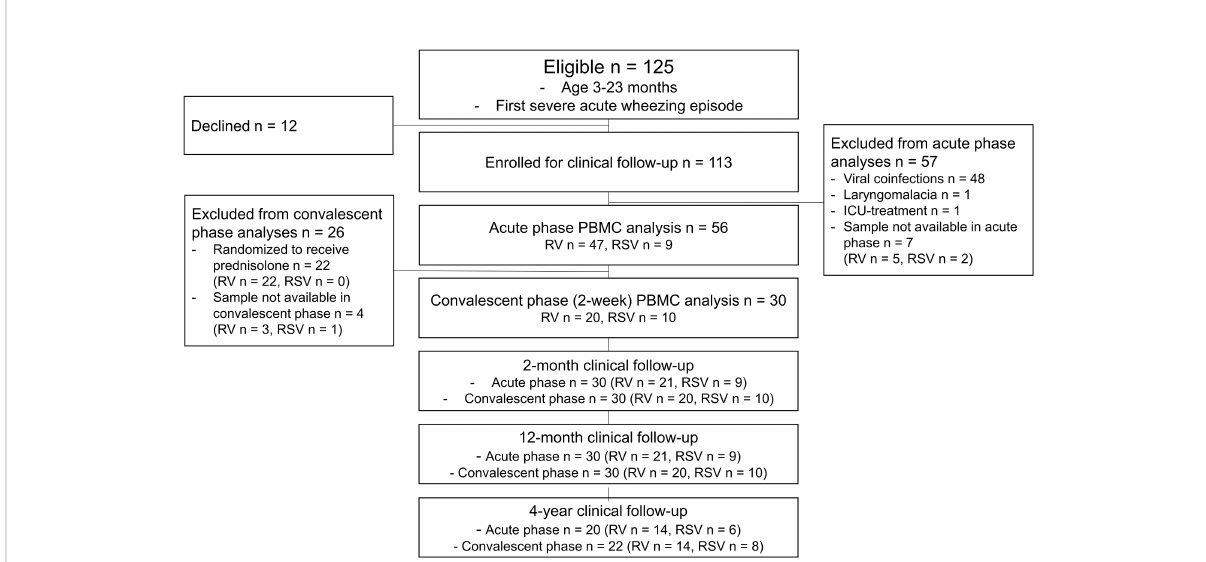
FIGURE 1 Study fl owchart. Patients with cytology data were included. ICU, intensive care unit; PBMC, peripheral blood mononuclear cell; RSV, respiratory syncytial virus; RV,